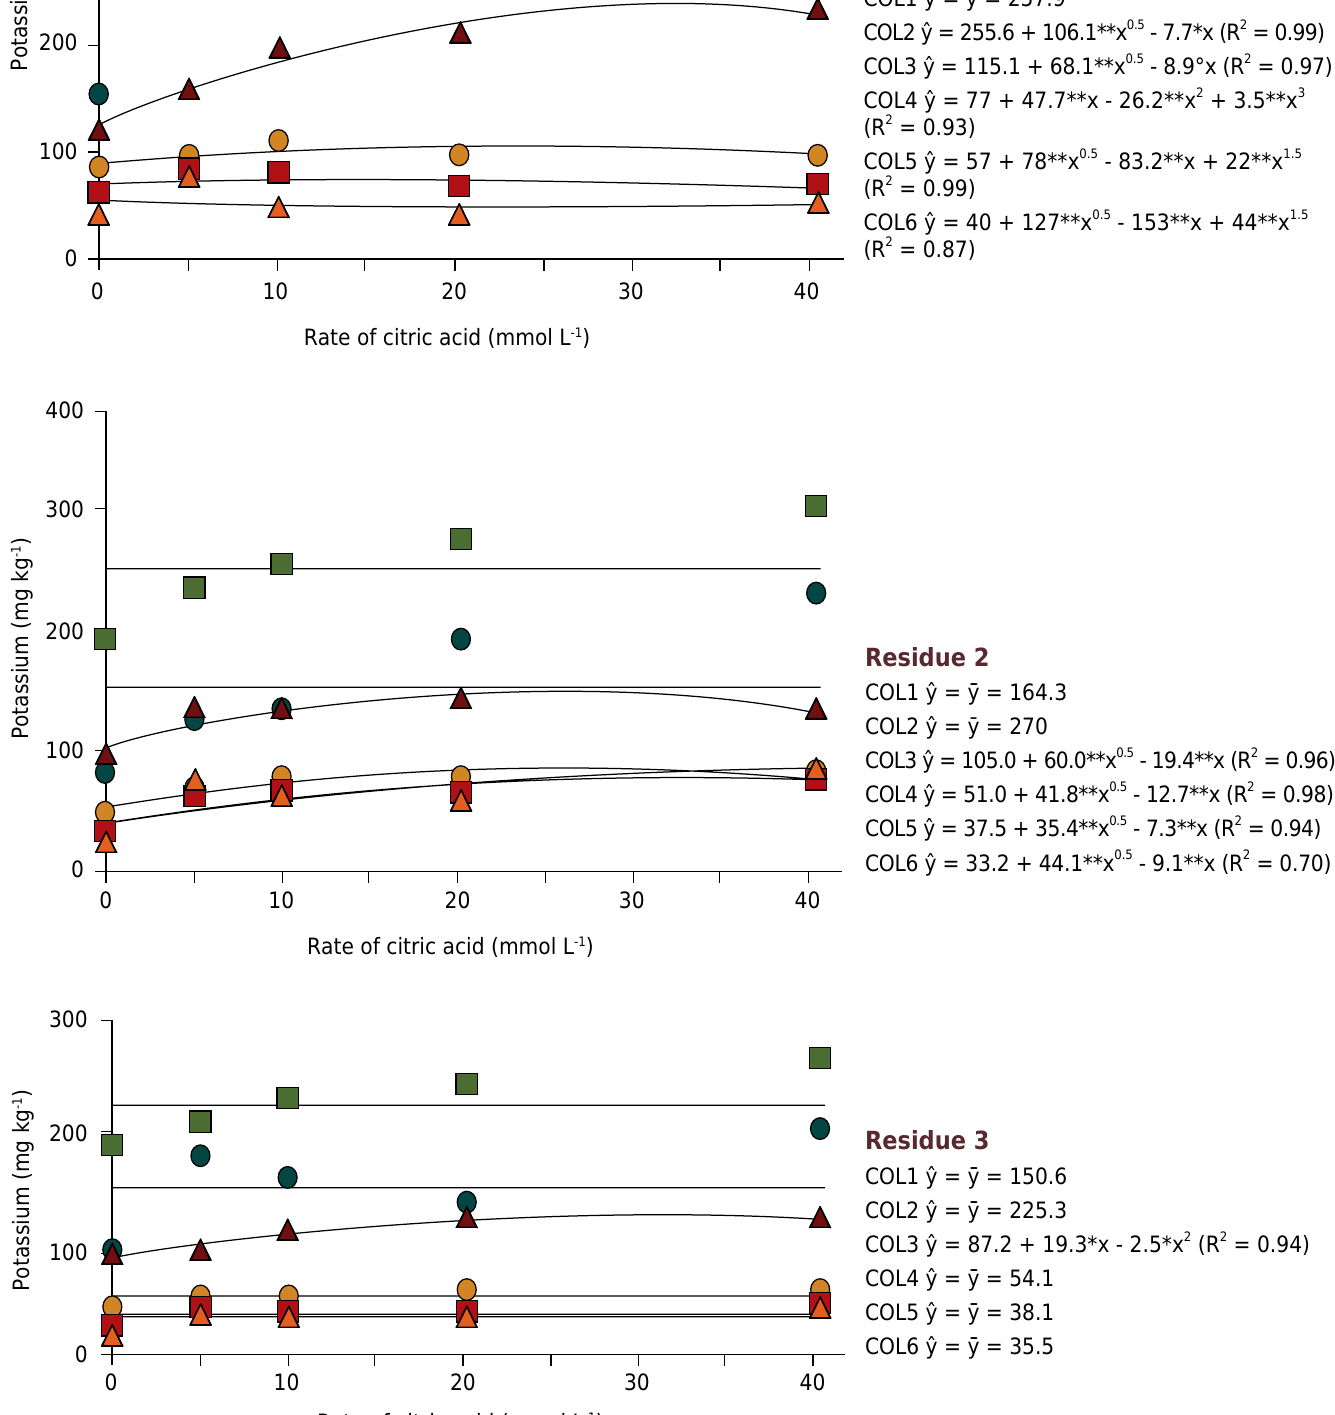
Figure 3. Potassium extracted from the residues (R1, R2, R3) at six sampling times (1, 5, 10, 15, 30 and 60 days, respectively, COL1, COL2, COL3, COL4, COL5, COL6), with the application of different rates of malic acid (MA). **, * and ° : significant at 1, 5 and 10 %,